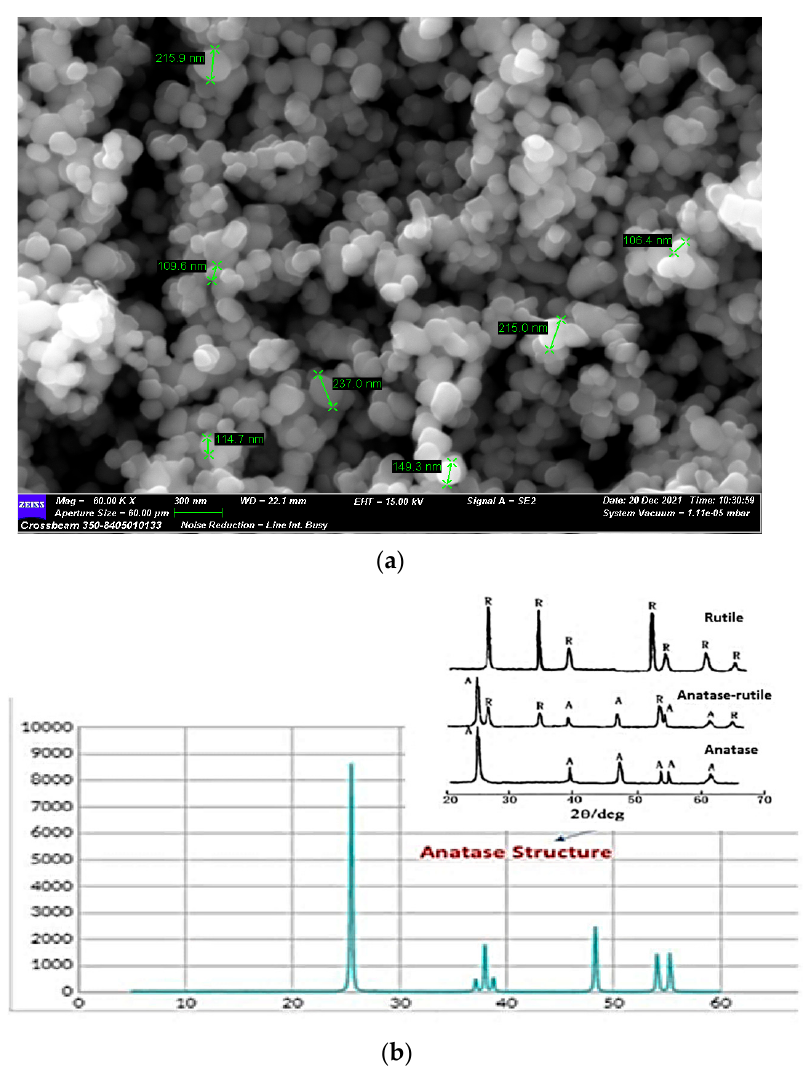
Figure 3. The structure analysis of commercial TiO 2 : ( a ) SEM picture and ( b ) XRD di ff raction pa tt ern.